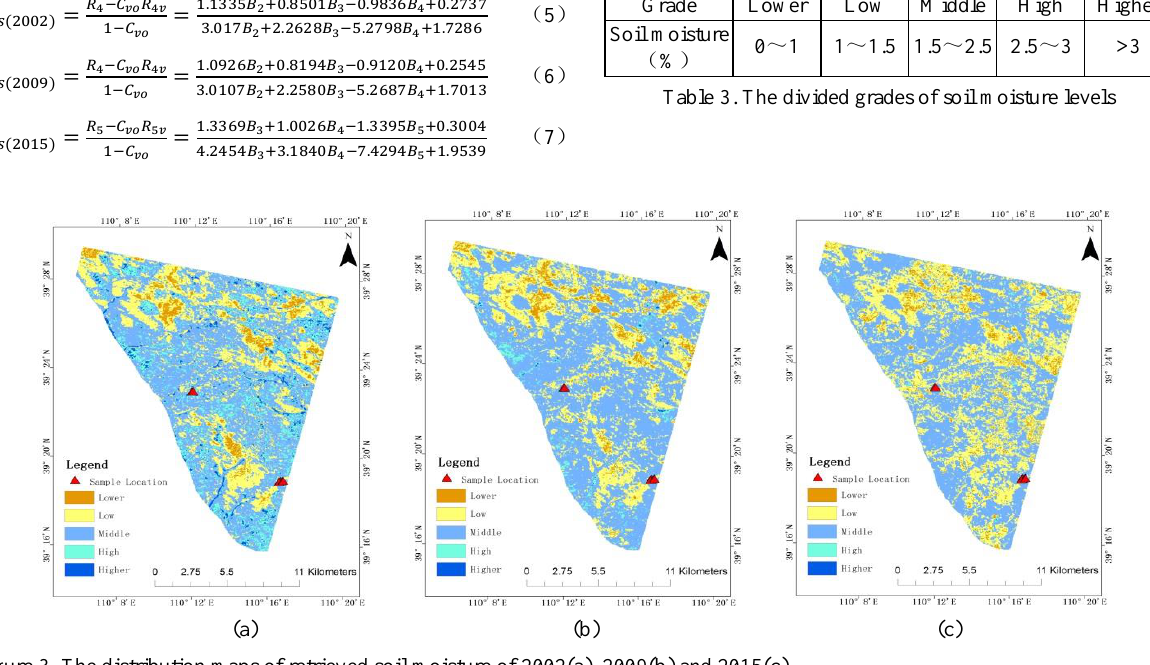
Figure 3. The distribution maps of retrieved soil moisture of 2002(a), 2009(b) and 2015(c) In order to further analyze the changed status of soil moisture content, the transfer matrix of soil area with different moisture level between 2002 and 2009 as well as 2009 and 2015 were established by formula (9) based upon the modeling function of ERDAS9.2